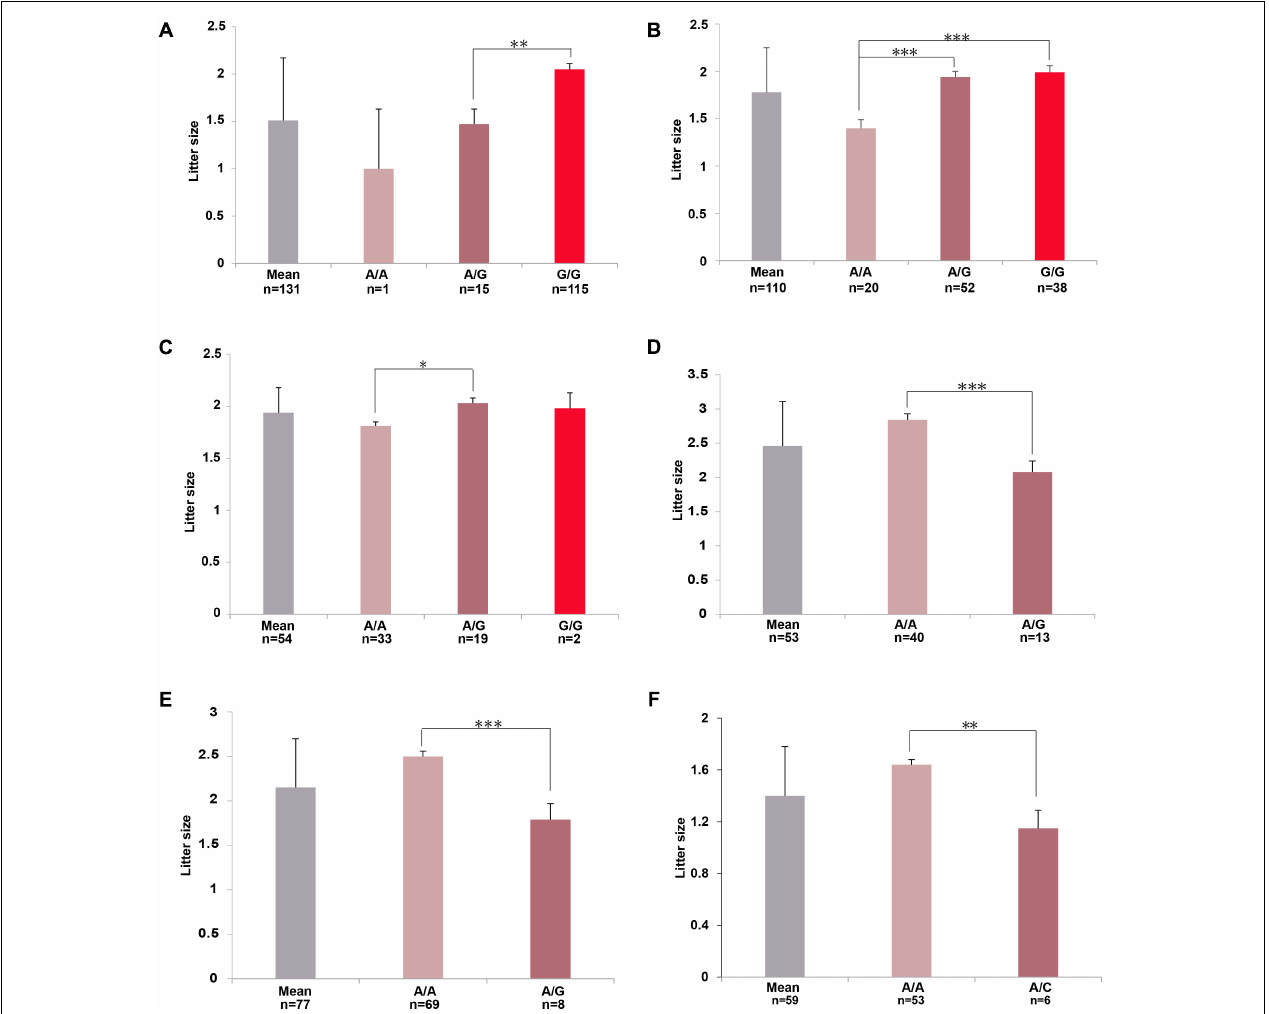
FIGURE 5 | Genotypic distributions of the top significant SNPs for the litter size (LS) phenotype in (A) Wadi, (B) Hu, (C) Icelandic, (D) Finnsheep, (E) Romanov, and (F) Texel sheep, respectively. The means LS were calculated for various breeds. Number of ewes per group of genotype is mentioned. Pairwise statistical comparisons between means of genotype’s clades were performed using Student’s t -test. ∗ p < 0.05, ∗∗ p < 0.01, ∗∗∗ p <